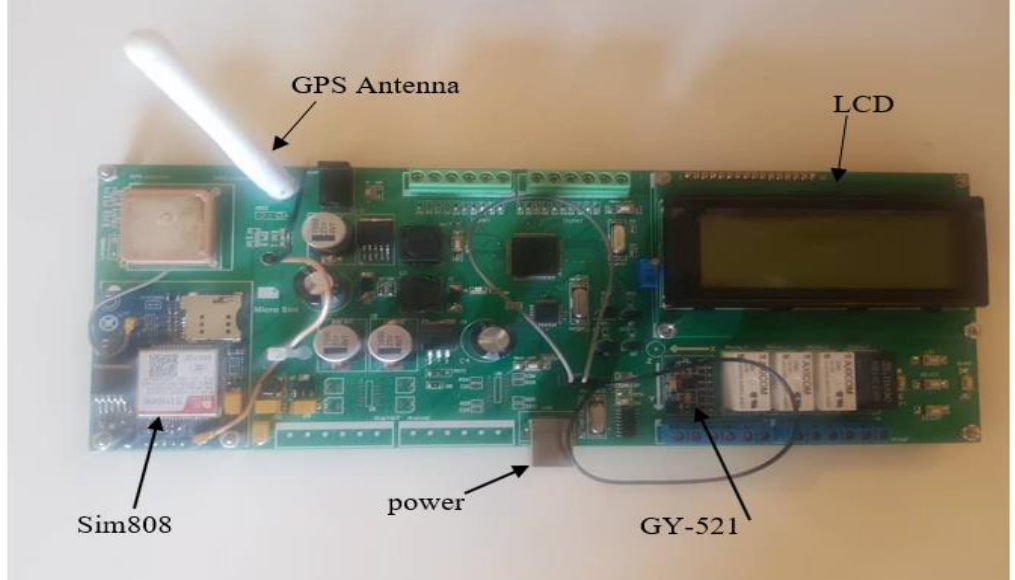
Figure 2. The components of the main board including LCD, GPS, Sim808, Power, and GY-521